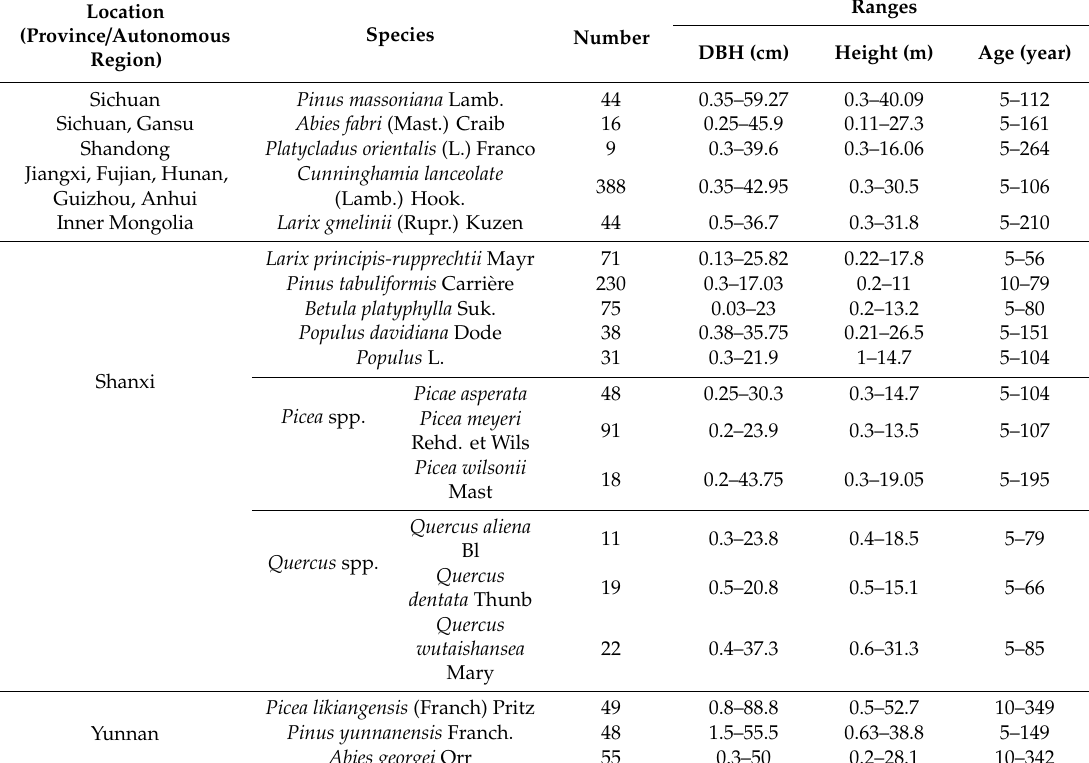
Table 1. Model establishment and testing data for di ff erent tree